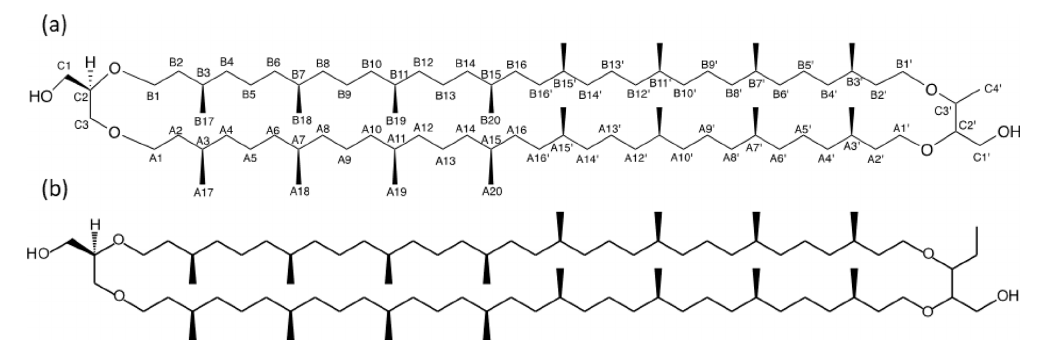
Figure 2. Detailed structure of (a) BDGT-0 isolated from M. luminyensis and (b) hypothetical structure of PDGT-0 based on Zhu et al. (2014). Carbon numbers in (a) correspond to those given in Table 1, with C4 (cid:48) representing the additional carbon detected in